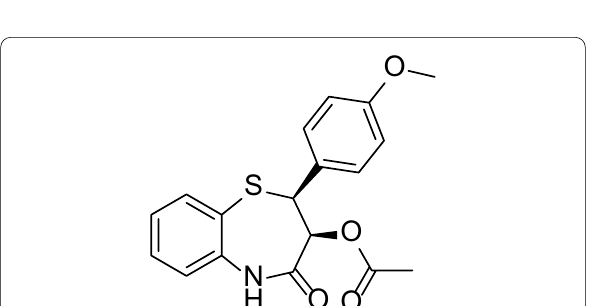
Fig. 5 Chemical structure of diltiazem EP